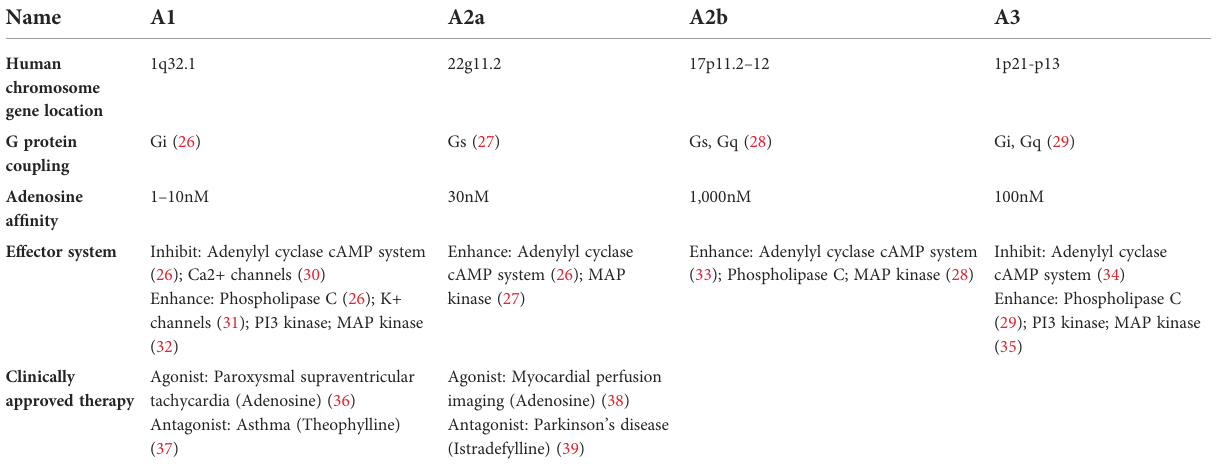
TABLE 1 Characteristics of adenosine receptors.